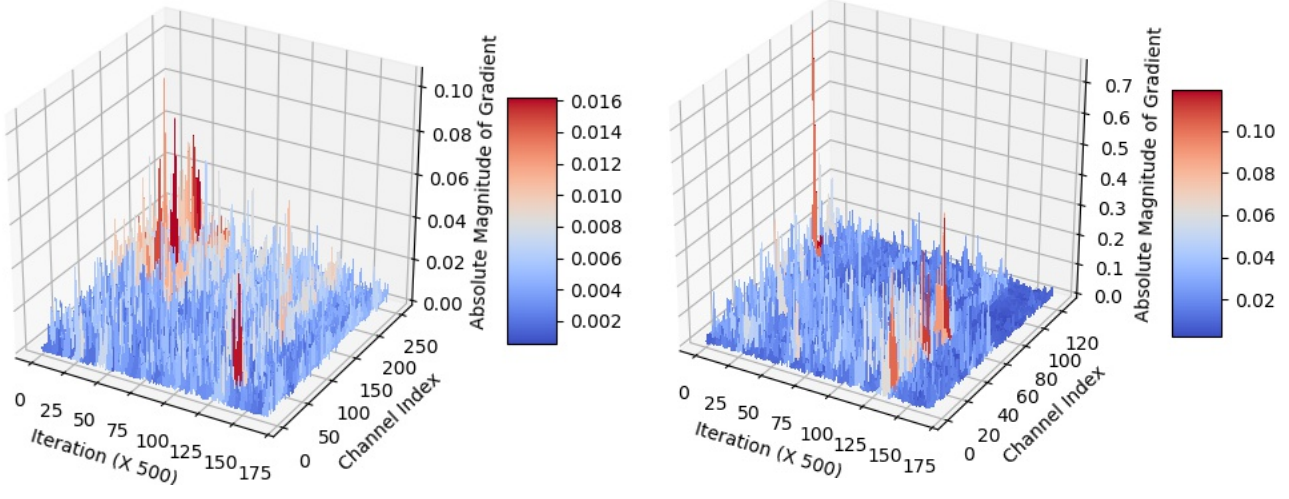
Figure 12. The amplitude of loss gradients with respect to the convolution weights in the skip- connected decoder layers during the learning process: The gradients are drawn every 500 iterations. The former half of the channels are for the decoded feature from the previous scale, and the latter half are for the skip-connected feature from the